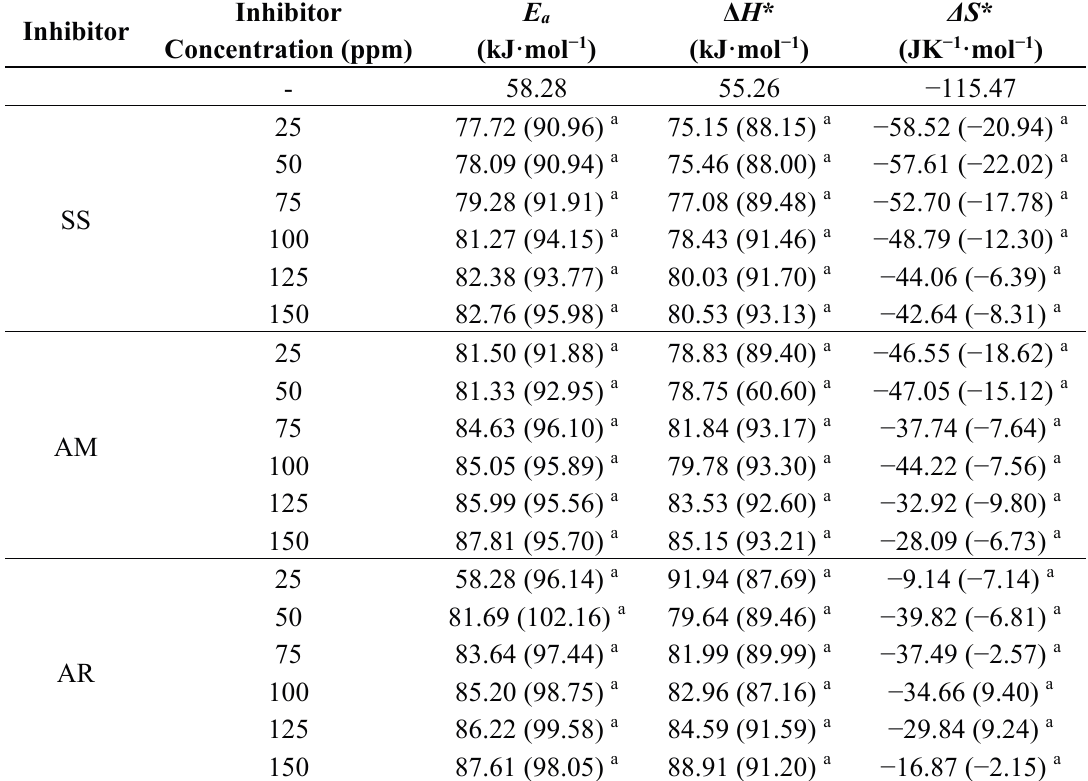
Table 1. Activation parameters E a , Δ H * and Δ S * derived from the Arrhenius plots in the absence and presence of different concentrations of the studied